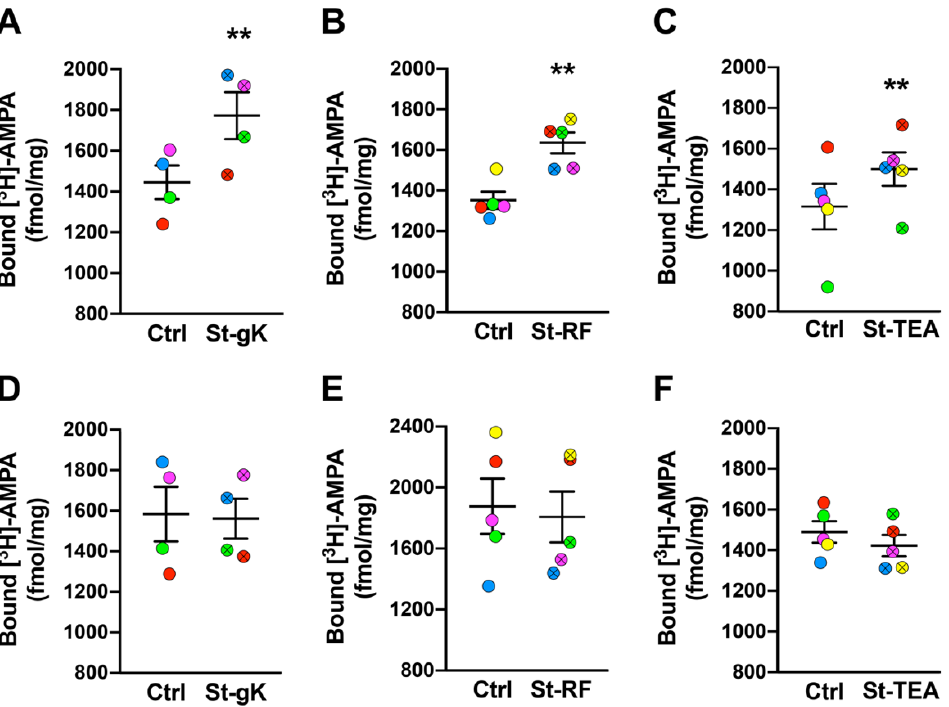
Figure 2. Chemically induced long-term potentiation (cLTP) in rat cortical synaptosomes ( A – C ) is abolished by latrunculin A ( D – F ). All three chemical stimulation protocols, glycine-KCl (St-gK; A ), rolipram-forskolin (St-RF; B ) and TEA (St-TEA; C ), resulted in elevated surface AMPAR expression in rat cortical synaptosomes relative to their corresponding non-stimulation matched controls (Ctrl). However, latrunculin A (200 nM; a blocker of actin polymerization) completely abolished cLTP- induced insertion of AMPARs on rat synaptosomal membranes following the stimulations by gly- cine-KCl ( D ), rolipram-forskolin ( E ) and TEA ( F ). Results are expressed as mean (±SEM) bound [ 3 H]- AMPA ( n = 4 – 6 for each experiment). ** represents a statistical significance at p < 0.01. The respective pairs of stimulated and unstimulated synaptosomes are color coded in each panel.